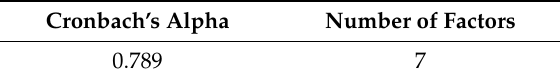
Table 14. Cronbach’s alpha factor for factors of the importance of relationships with Customers 4.0 for the development of innovative